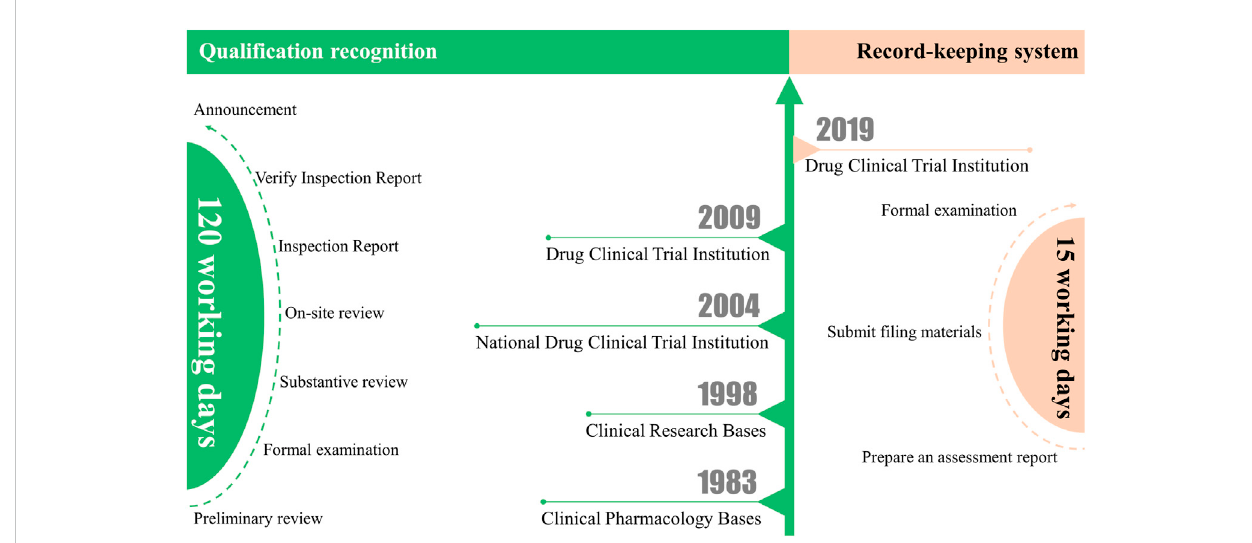
FIGURE 1 From quali fi cation recognition to record-keeping system: Differences between the clinical trial institution quali fi cation recognition and the record- keeping system.